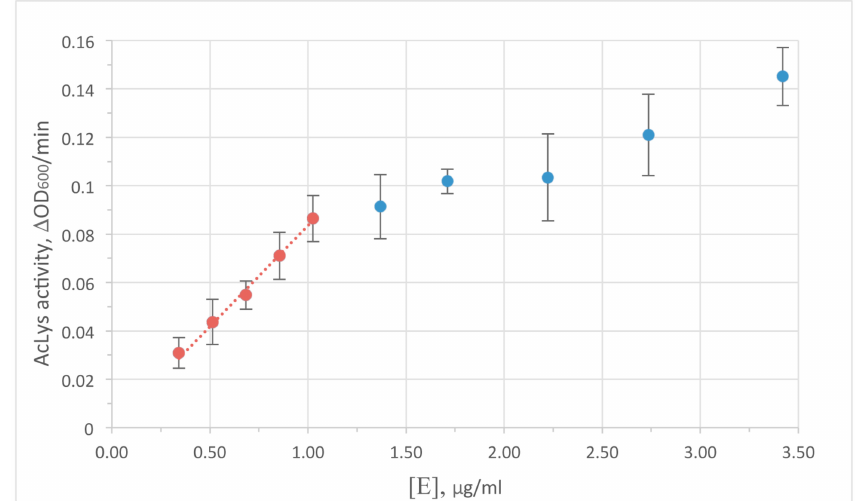
Figure 2. Dependence of AcLys activity on the enzyme concentration in the reaction mixture. An initial density of bacterial cell suspension OD 600 = 0.6. The substrate is E. coli CR63 preliminary washed with deionized water and frozen at − 70 ◦ C. Reaction conditions 20 mM Bis-Tris (pH 6.0), 25 ◦